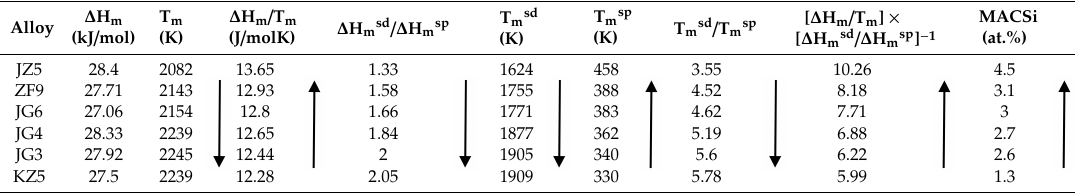
Table 5. Alloy parameters for the macrosegregation of Si in the cast alloys JZ5, ZF9, JG6, JG4, JG3 and